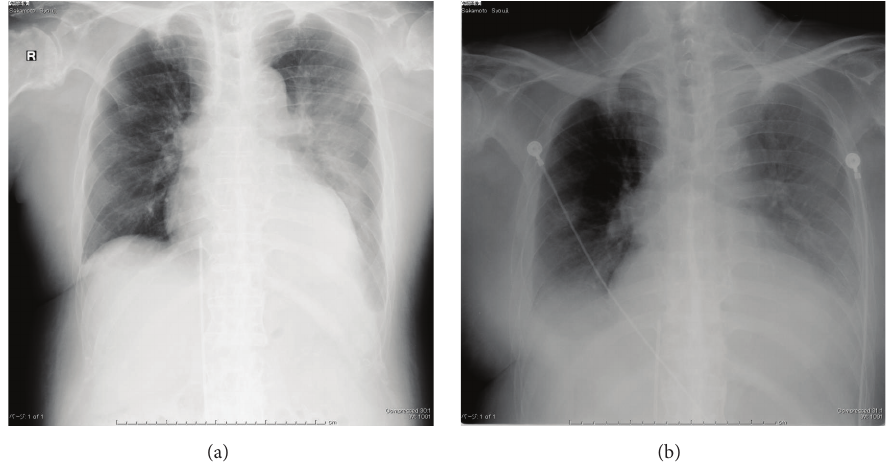
Figure 3: Progressive respiratory failure of the patient ((a) 1 hour after injury and (b) 18 hours after